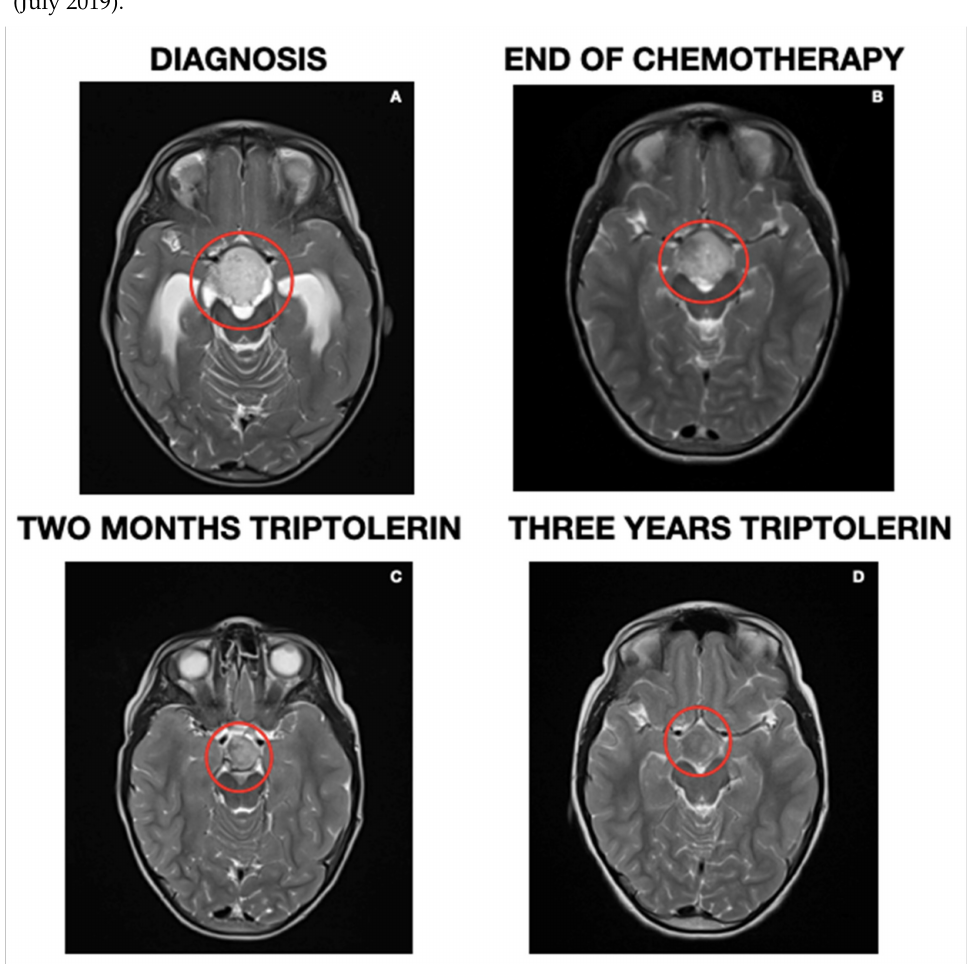
Figure 4. Magnetic resonance image at four different moments: at debut ( A ), end of treatment ( B ), after two months of hormonal treatment ( C ), and current image ( D